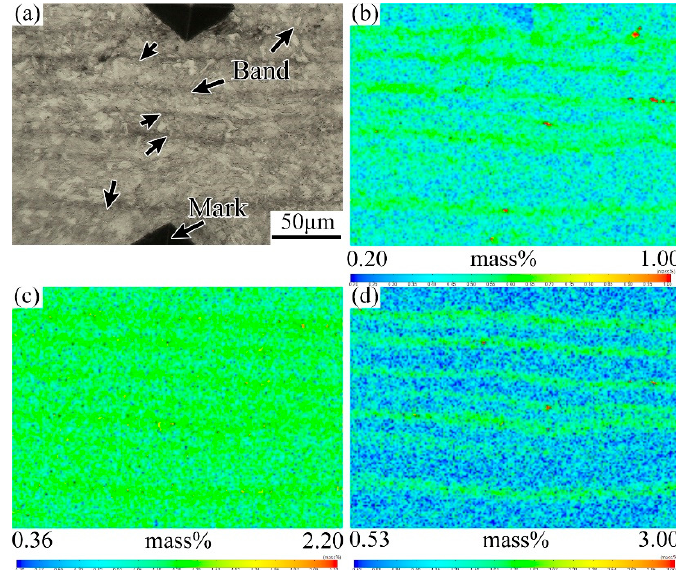
Figure 10. EPMA analysis of map scanning on the banded structure of QT1 sample. ( a ) Optical micrograph of the banded structure; ( b ) EPMA maps of element C; ( c ) EPMA maps of Cr; ( d ) EPMA maps of Mo.